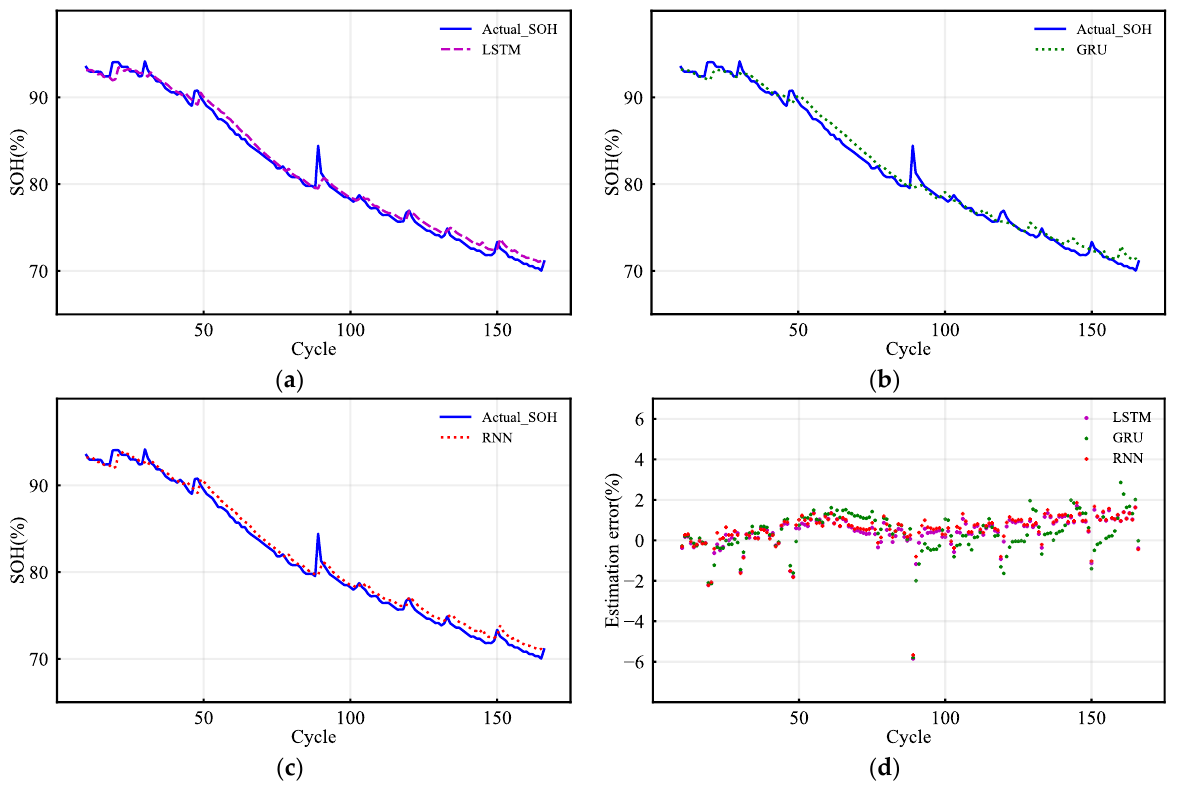
Figure 9. ( a ) SOH estimation results of the LSTM-RNN; ( b ) SOH estimation results of the GRU-RNN; ( c ) SOH estimation results of the Sim-RNN; ( d ) estimation errors of the LSTM-RNN, Sim-RNN, and GRU-RNN. Table 2. The RMSE and MAE results from the testing of battery B0007.